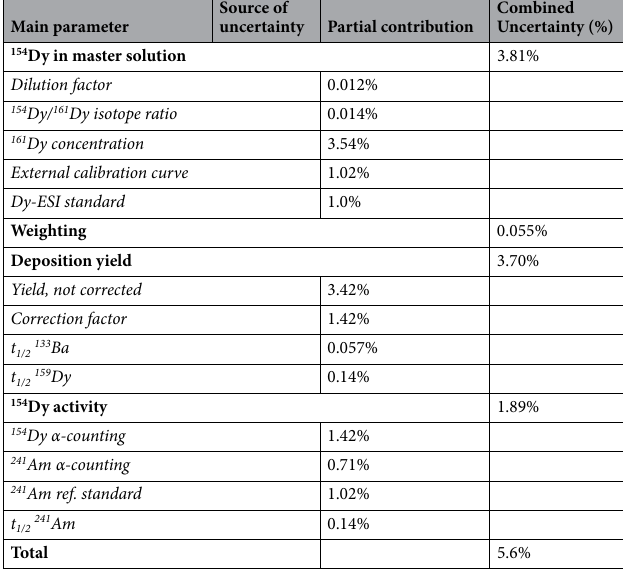
Table 4. Uncertainties budget (with k = 1) for the 154 Dy half-life measurement.